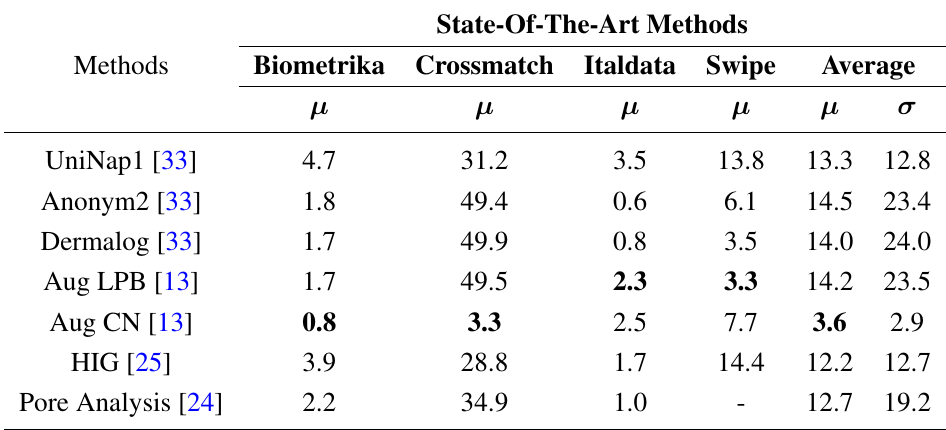
Table 7. Results of state-of-the-art methods (ACER and average in %